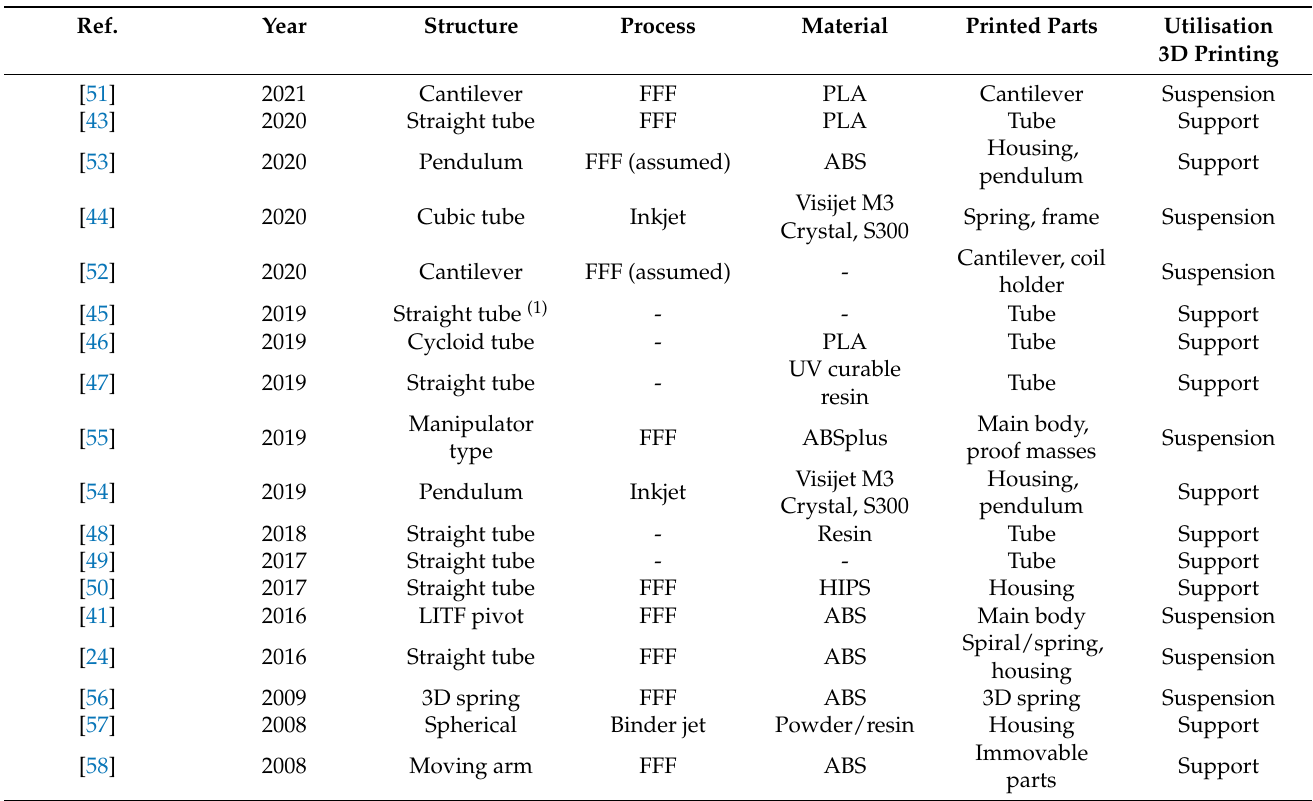
Table 4. Comparison of applied 3D printing techniques for electromagnetic vibration harvesters. Ref.